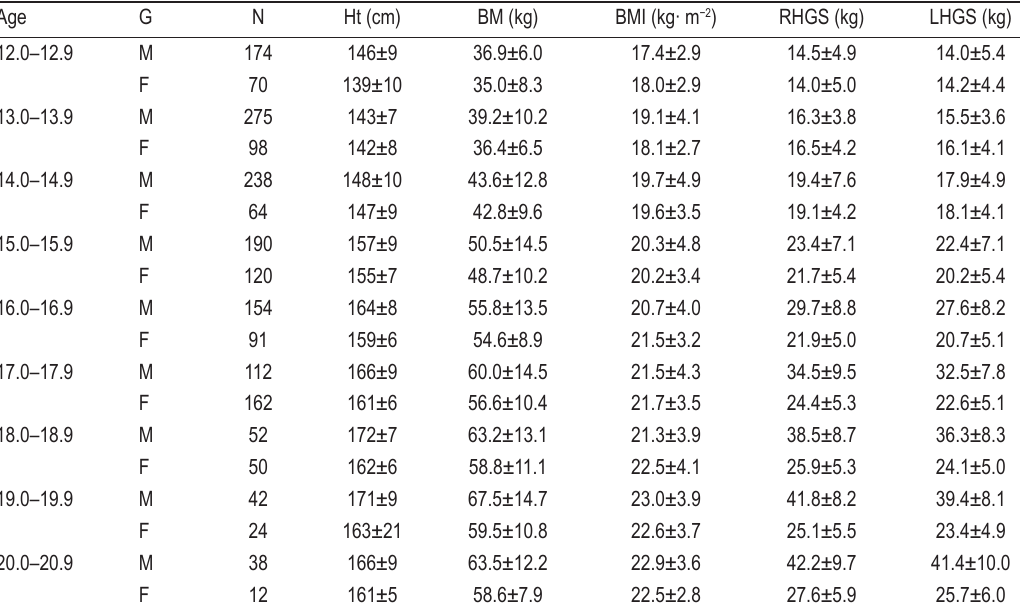
FIGURE 1. Gender and age differences in handgrip strength of the participants. TABLE 1. Height, body mass, body mass index, right, and left handgrips strength of the participants stratified by gender and age